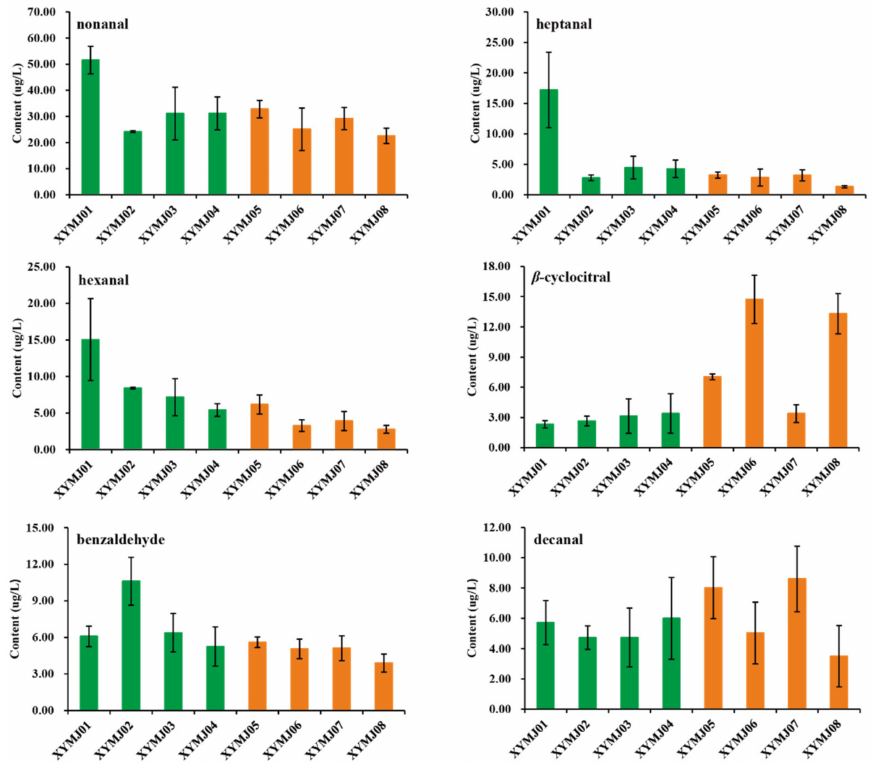
Figure 3. Various change trends of the aldehydes in XYMJ green teas. All data are expressed as mean ± S.D. ( n =